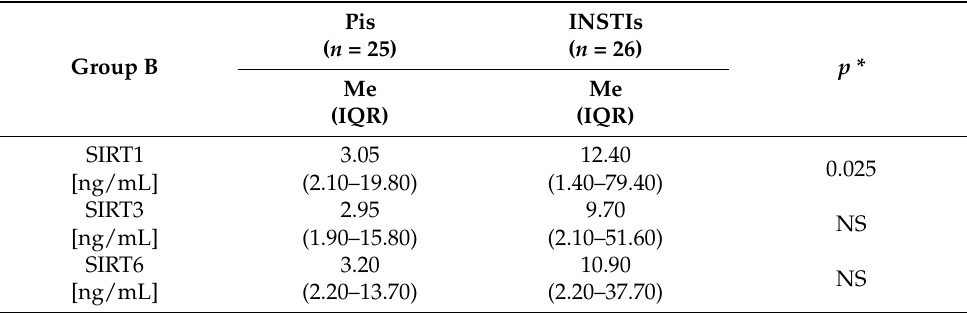
Table 7. Results for SIRT1, SIRT3 and SIRT6 in the plasma of HIV-infected men after cART ( B ) in the subgroup treated with Protease inhibitors (PIs) and the subgroup treated with Integrase transfer inhibitors (INSTIs) with statistical